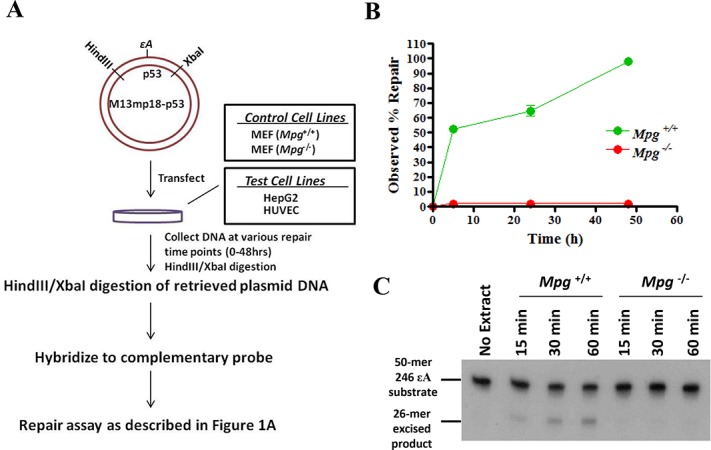
Experimental design and method validation in cells. (A) Schematic representation of in-cell repair assay. (B) Repair of 246εA in wild-type (Mpg+/+) and Mpg−/− MEFs as measured by real time PCR. (C) MPG excision activity on 246εA oligonucleotide substrate in Mpg+/+ and Mpg−/− MEF nuclear extract. Reactions were incubated at 37°C for 15, 30 and 60 min before termination at 65°C.